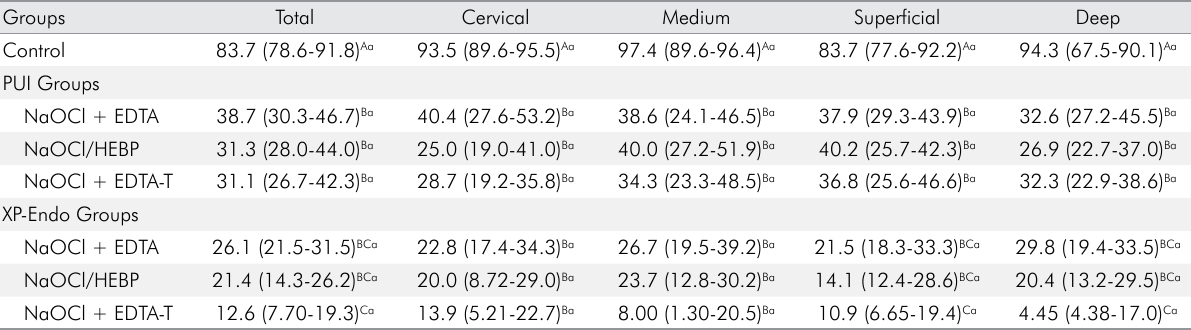
Table 2. Median (95% confidence interval) percentage of viable bacteria in the dentinal tubules after treatment of each